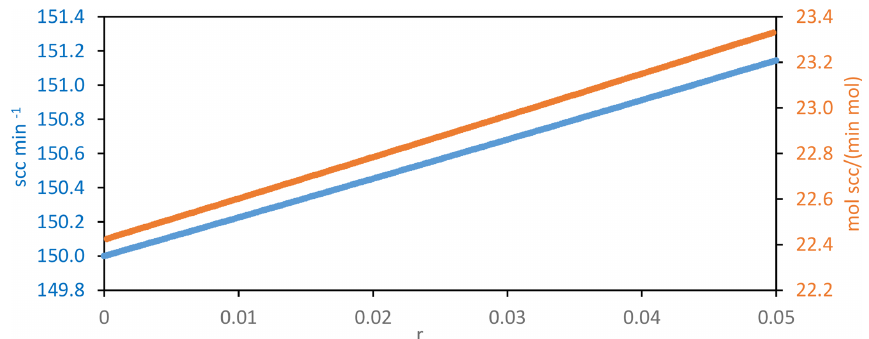
Figure A1. Standard volumetric flow ( F ) on the left y axis and its derivative with respect to r (H 2 O mole fraction in molmol − 1 ) on the right y axis, for p i = 700hPa and T i = 293K.